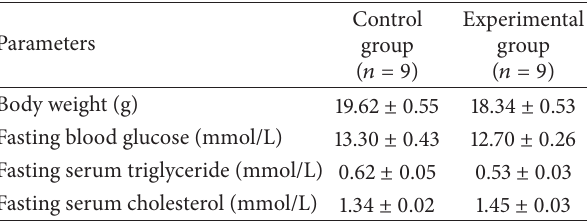
Table 1: Results of clinical characterization of animals used for the